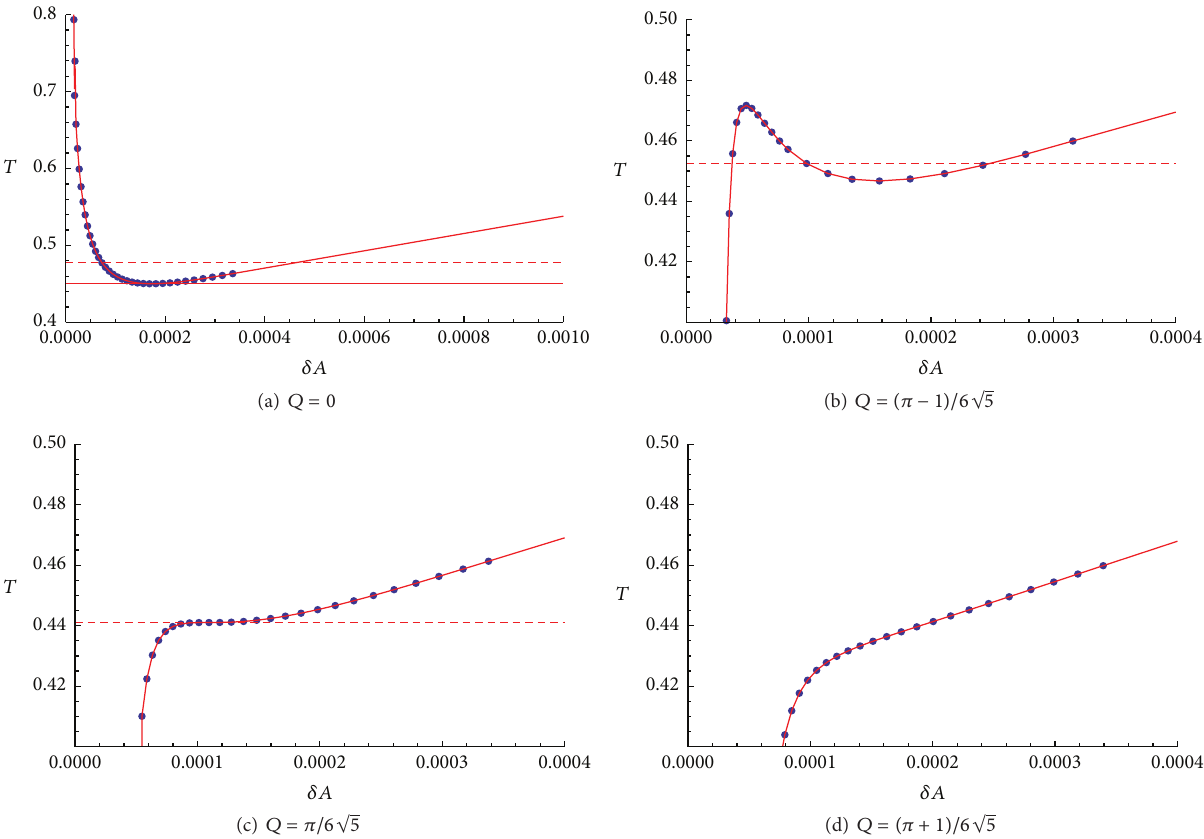
Figure 7: Relation between the minimal area surface and temperature in the fixed charge ensemble for different charges at 𝜃 0 = 0.2 . The red solid line corresponds to the location of the minimum temperature 𝑇 0 ; the dashed lines in (a), (b), and (c) correspond individually to the locations of Hawking-Page phase transition 𝑇 1 , first-order phase transition 𝑇 ⋆ , and second-order phase transition 𝑇 𝑐